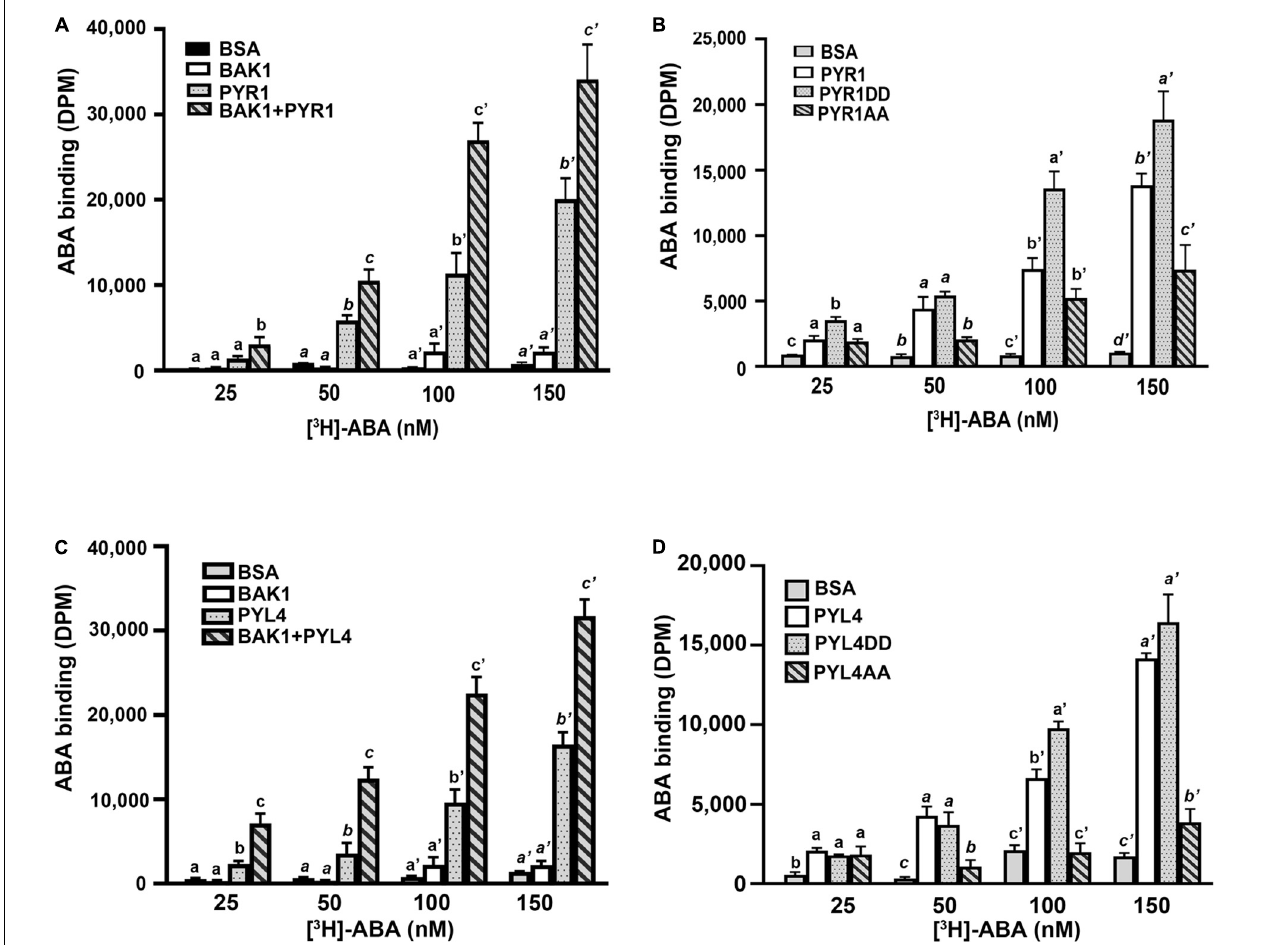
FIGURE 5 | BAK1 phosphorylation of PYR1 or PYL4 increased ABA binding capacity. (A) BAK1 increases the ABA-binding affinity of PYR1 in vitro . PYR1 was phosphorylated by BAK1 and then incubated with [ 3 H]-ABA. A total of 2 µ g of HIS-PYR1, HIS-BAK1, or BSA were used for each experiment. ABA-binding activity without [ 3 H]-ABA was 29 ± 4, 31 ± 2, 28 ± 11, and 36 ± 9 DPM for BSA, BAK1, PYR1, and PYR1+BAK1, respectively. Experiments were repeated thrice. (B) ABA-binding capacity varied depending on phosphorylation of PYR1 by BAK1. An in vitro ABA-binding assay was performed with the phosphomimetic (PYR1DD) and phospho-dead (PYR1AA) PYR1 and compared with results using native PYR1 or BSA as a negative control. ABA-binding activity without [H 3 ]-ABA was 17 ± 5, 47 ± 17, 34 ± 10, and 38 ± 6 DPM for BSA, PYR1, PYR1DD, and PYR1AA, respectively. Three independent experiments were performed. (C) BAK1 increases the ABA-binding affinity of PYL4 in vitro . PYL4 was phosphorylated by BAK1 and then incubated with [H 3 ]-ABA. Approximately 2 µ g each of HIS-PYL4, HIS-BAK1, or BSA was used in each experiment. ABA-binding activity without [3H]-ABA was 29 ± 5, 31 ± 2, 16 ± 3, and 31 ± 4 DPM for BSA, BAK1, PYL4, and PYL4+ BAK1, respectively. Data were analyzed using one-way ANOVA and Tukey’s multiple comparisons test; P < 0.05. Different letters indicate statistically significant data under the indicated concentrations of ABA. The experiments were repeated thrice. (D) Phosphorylation of PYL4 by BAK1 is required for ABA binding by PYL4. In vitro ABA-binding assays were performed with phosphomimetic (PYL4DD) and phospho-inactive PYL4 (PYL4AA) and were compared with ABA binding of native PYL4 or BSA as a negative control. ABA-binding activity without [ 3 H]-ABA was 21 ± 4, 24 ± 9, 30 ± 14, and 45 ± 13 DPM for BSA, PYL4, PYL4DD, and PYL4AA, respectively. Three independent experiments were performed. Data were analyzed using one-way ANOVA and Tukey’s multiple comparisons test; P < 0.05. Different letters indicate statistically significant data under the indicated PYL4